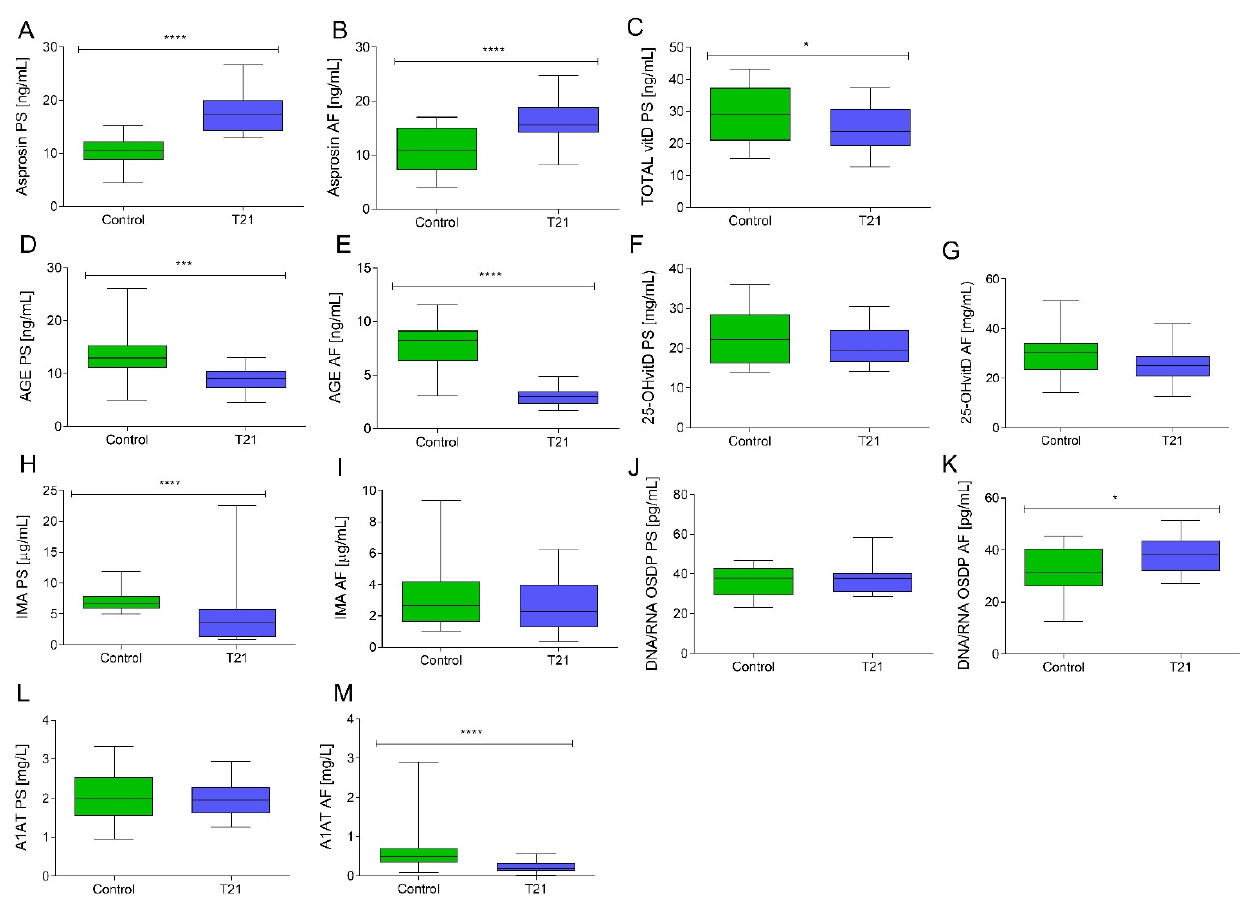
Figure 1. The studied protein concentrations measured in the plasma and amniotic fluid samples. Different asterisks above the bars indicate significant differences compared to the control (* p ≤ 0.05; *** p ≤ 0.001; **** p ≤ 0.0001). ( A ) Plasma asprosin; ( B ) amniotic fluid asprosin; ( C ) plasma total vitamin D; ( D ) plasma advanced glycation end products; ( E ) amniotic fluid advanced glycation end products; ( F ) plasma 25-OH vitamin D; ( G ) amniotic fluid 25-OH vitamin D; ( H ) plasma ischemia-modified albumin; ( I ) amniotic fluid ischemia-modified albumin; ( J ) plasma DNA/RNA oxidative stress damage product; ( K ) amniotic fluid DNA/RNA oxidative stress damage products; ( L ) plasma alfa-1-antitrypsin; ( M ) amniotic fluid alfa-1-antitrypsin. A1AT, alfa-1-antitrypsin; AF, amniotic fluid; AGE, advanced glycation end products; Control, control group; IMA, ischemia-modified albumin; OSDP, oxidative stress damage product; PS, plasma; T21, trisomy 21. Table 1 substantiates all the parameters analyzed with the concentrations found in T21 and control samples and the statistical comparison results (Table 1). No differences were observed between T21 plasma and amniotic fluid 25-OH vitamin D concentrations ( p > 0.05). However, 25-OH vitamin D in the control group was higher in amniotic fluid than in plasma samples ( p < 0.01). In the case of asprosin and DNA/RNA OSDP, no differences were noted between plasma samples and amniotic fluid in either euploid pregnancy or T21 groups ( p < 0.05). AGE and A1AT concentrations in the control and T21 groups were higher in plasma than in amniotic fluid (AGE: p < 0.01; p < 0.0001; A1AT: p < 0.001; p < 0.0001, respectively). Control group IMA concentrations were lower in amniotic fluid than in plasma samples ( p < 0.0001).